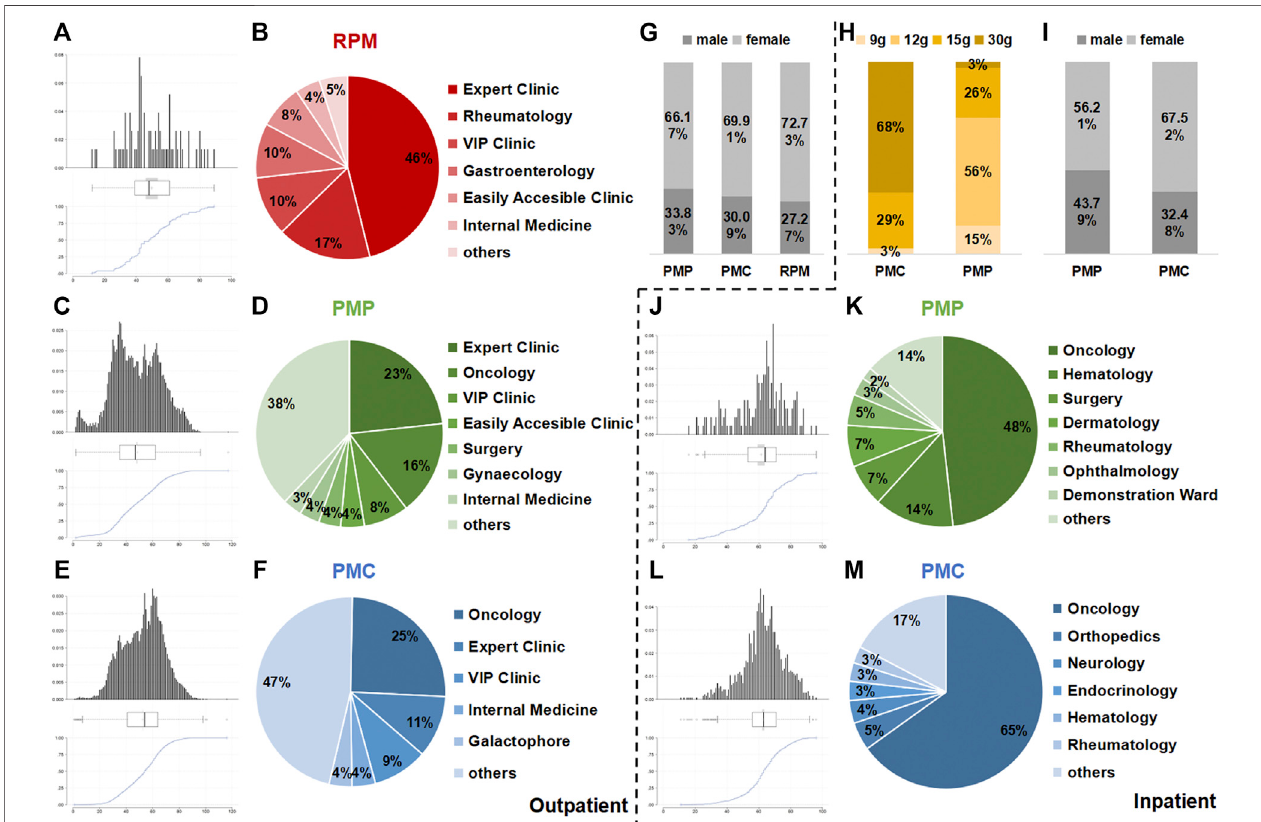
FIGURE 1 | Results of outpatient prescriptions and inpatient orders analysis. Age (A,C, and E) , department (B,D, and F) , sex (G) of outpatient prescriptions, age (J,L) ,department (K,M) ,sex (I) ,and dosage (H) ofinpatientorderscontainingRPM,PMPand PMCfromDecember1,2016toDecember 1,2017inLonghuaHospital.